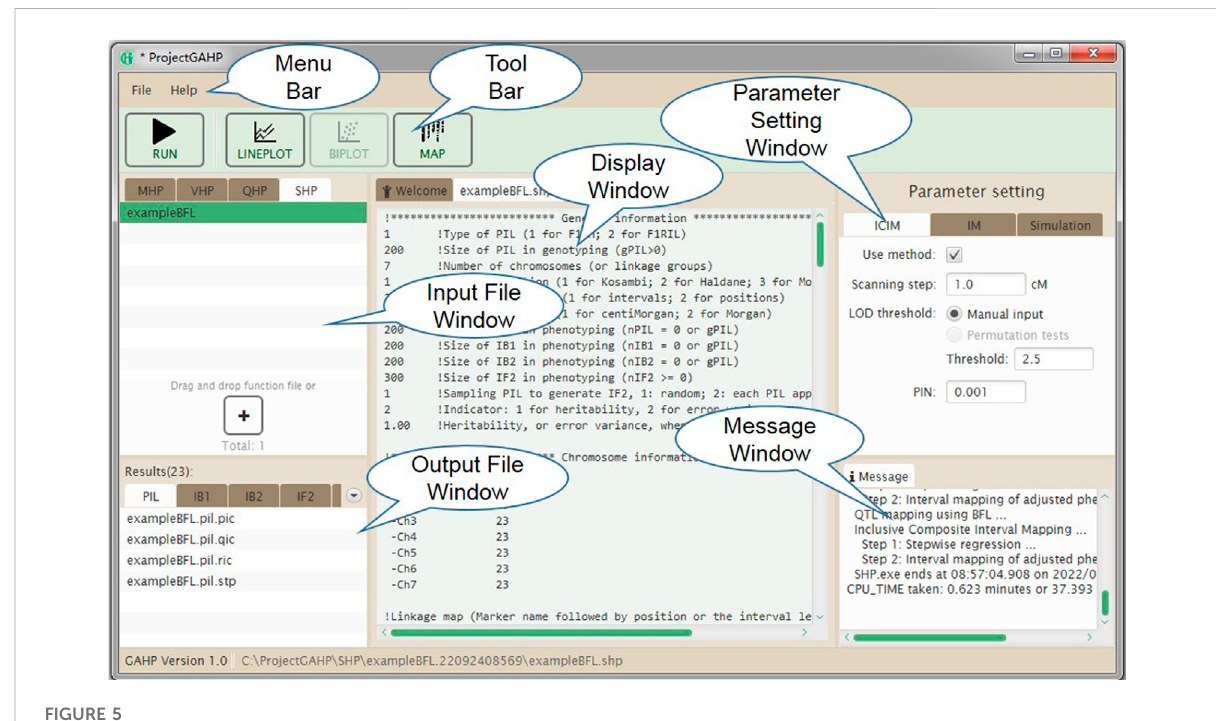
FIGURE 5 The interface of functionality